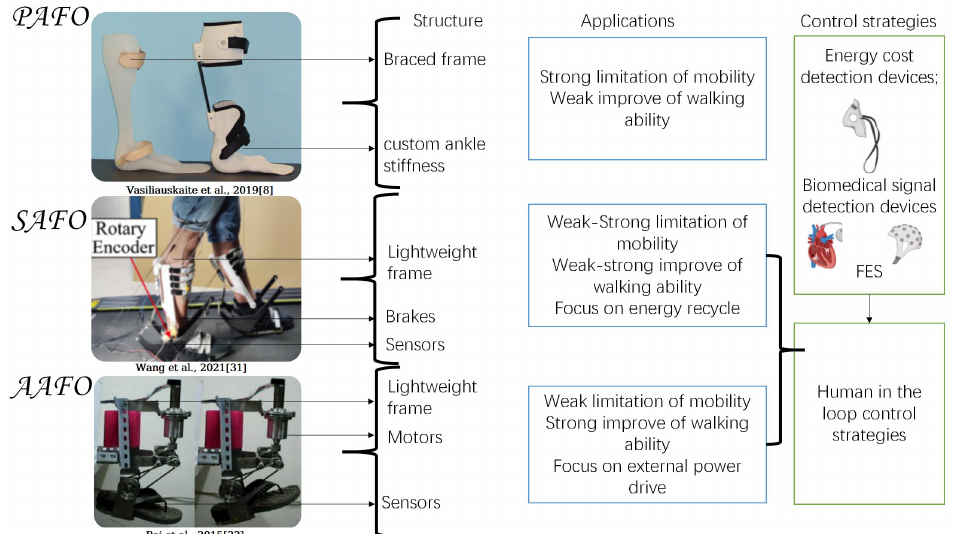
Figure 3. Structure, utilizations, and control strategies of